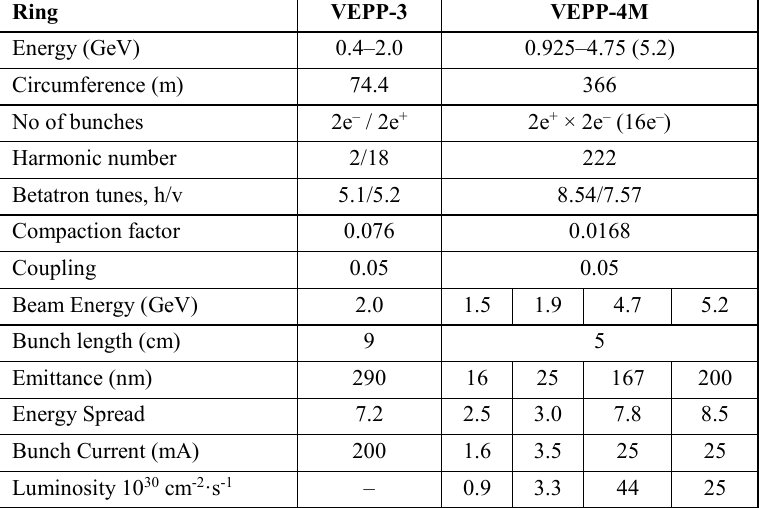
Table 2. Parameters of VEPP-3 and VEPP 4M storage